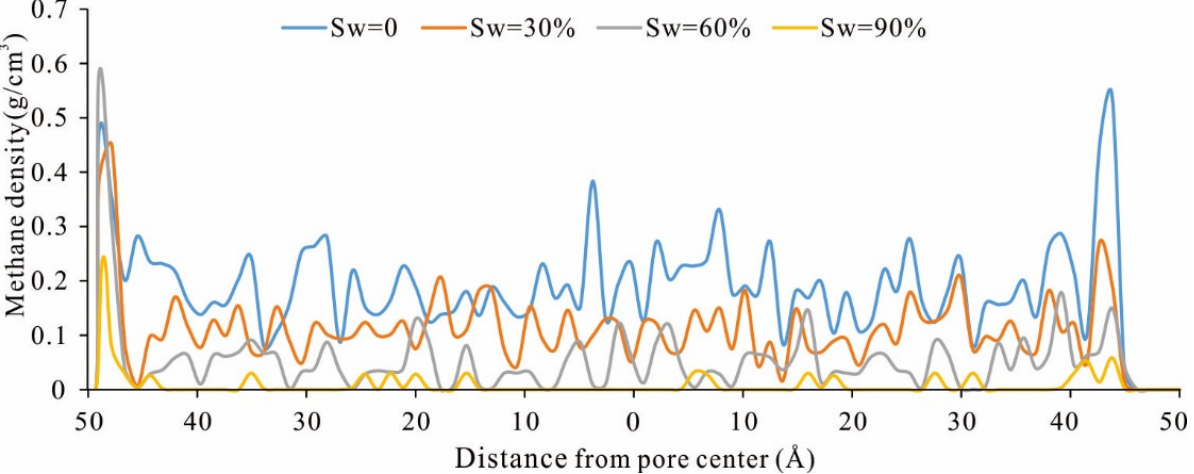
Figure 10. Modeled methane density in nano-scale clay-mineral pores under different levels of water saturation.